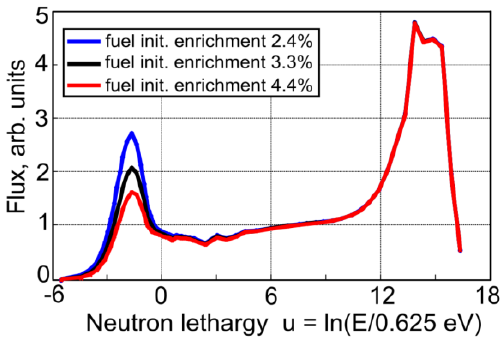
Figure 1. Example of calculated neutron flux spectra in a fuel pellet in WWER-1000 cells with the SVL code [7] (concentration of boric acid 2.8 g/kg, fuel temperature 1024